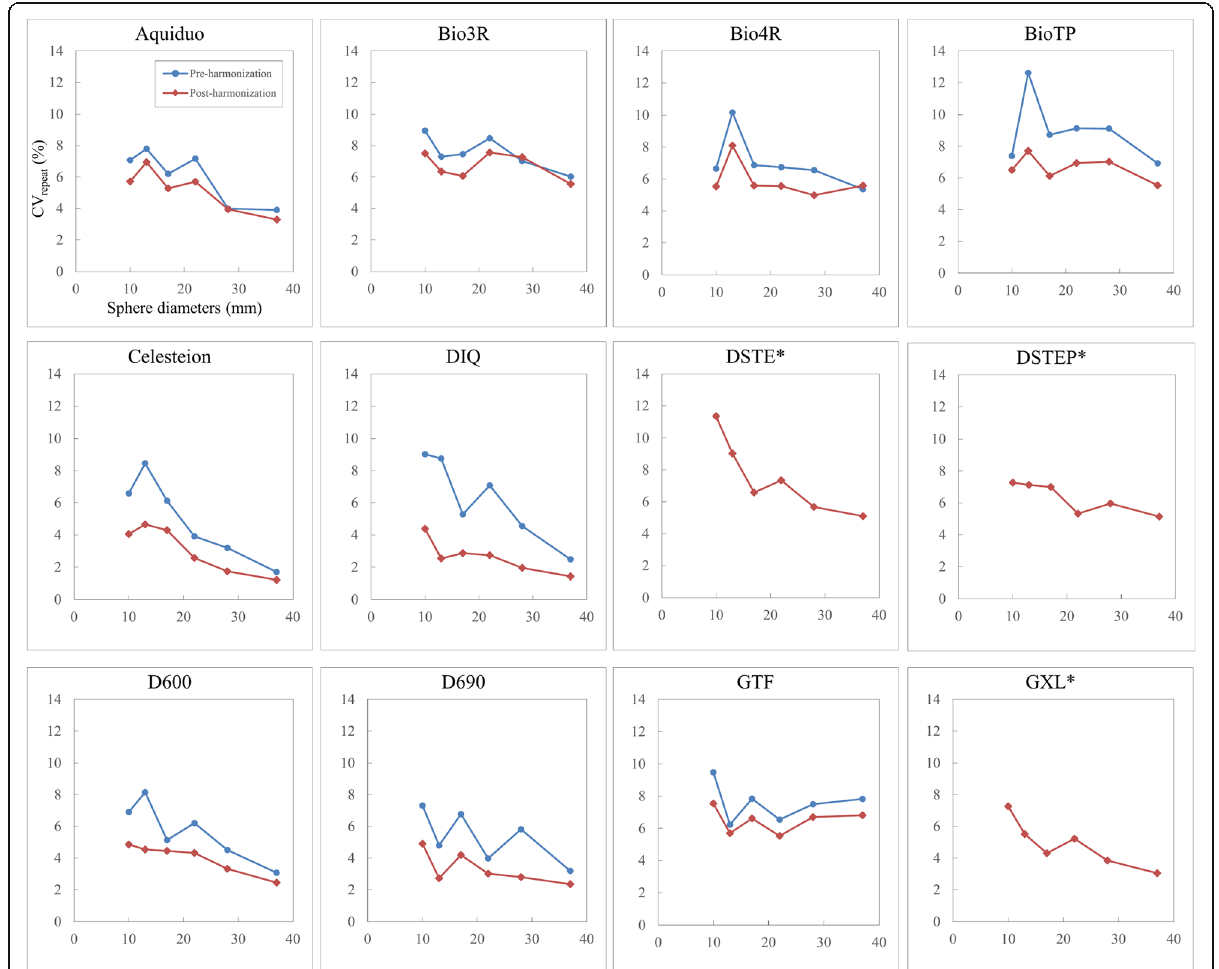
Fig. 5 Effects of harmonization on repeatability. Pre- and post-harmonization comparisons of coefficients of variation of the SUV max for 15 frames (CV repeat ). The asterisk symbol indicates three PET scanners (DSTE, DSTEP and GXL) did not require additional Gaussian filter for